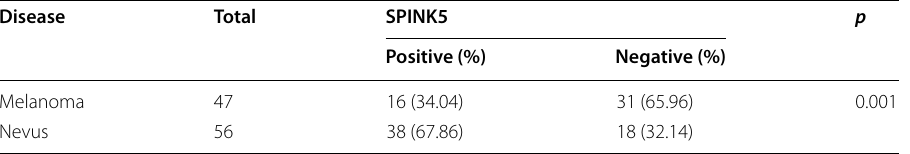
p < 0.05, statistically significant difference